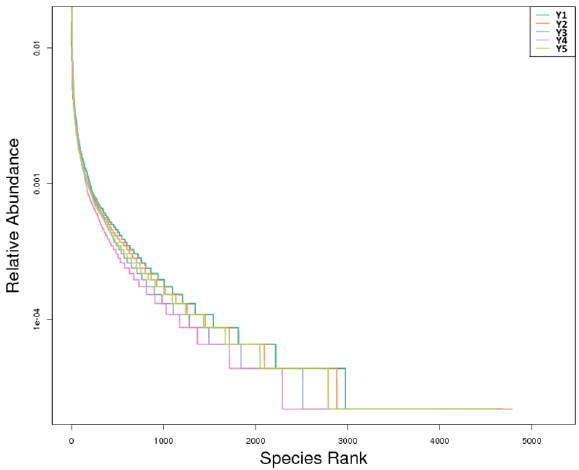
Figure 1. Rank abundance curve. In the horizontal direction, the wider the abscissa span, the higher the species richness; in the vertical direction, the smoother the curve, the higher the species